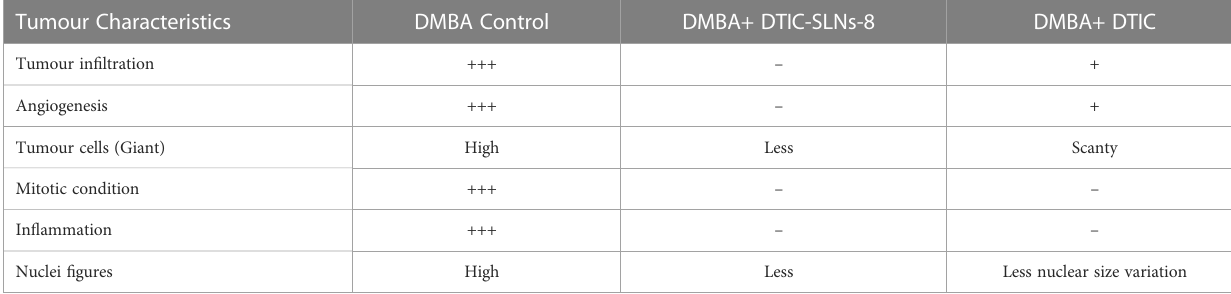
TABLE 6 Characteristics of DMBA tumours generated in